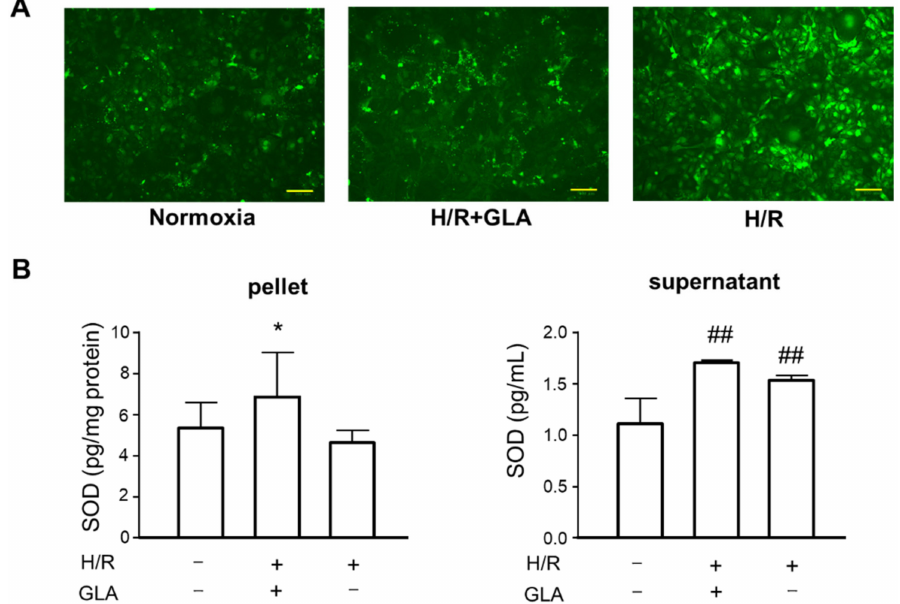
Figure 2. GLA inhibited H/R-induced oxidative stress in HK-2 cells. The cells were pre-treated with 5 µ M GLA for 2 h and then exposed to H/R for 24 h. ( A ) STAINING of ROS production in HK-2 cells using DCFH-DA. Scale bars = 100 µ m. ( B ) ELISA was conducted to assess the SOD activity in HK-2 cells. ## p < 0.01, vs. control (normoxia); * p < 0.05, vs. H/R. DCFH-DA: 2’-7’ dichlorofluorescin diacetate; GLA: glaucocalyxin A; H/R: hypoxia/reoxygenation; ROS: reactive oxygen species; SOD: superoxide dismutase. Data are shown as the means ± SE for six wells.